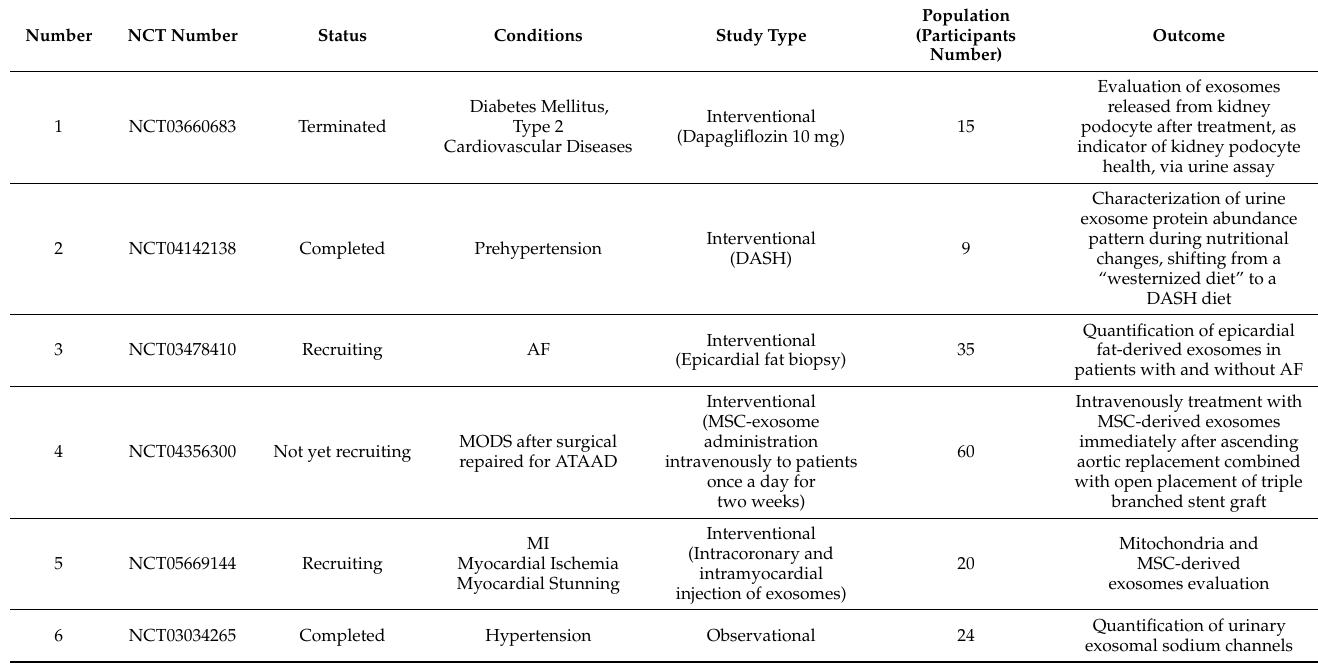
Table 1. Clinical studies of EVs’ evaluation as diagnostic biomarker for CVD